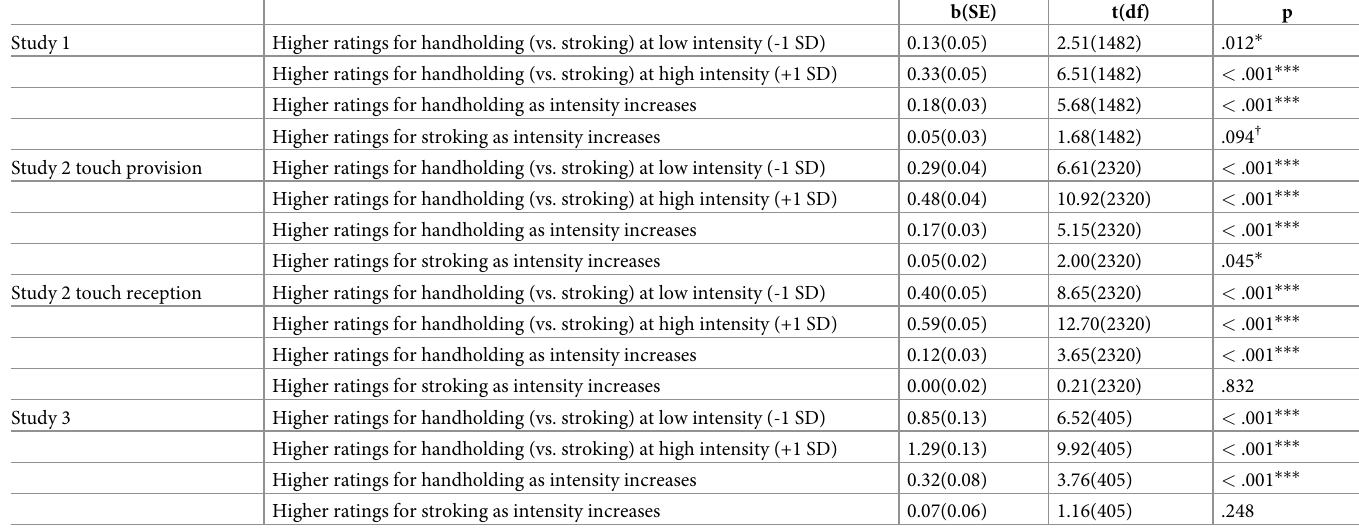
Table 5. Simple slope analyses for the interaction between intensity measured as a self-reported rating and touch type in Studies 1–3.